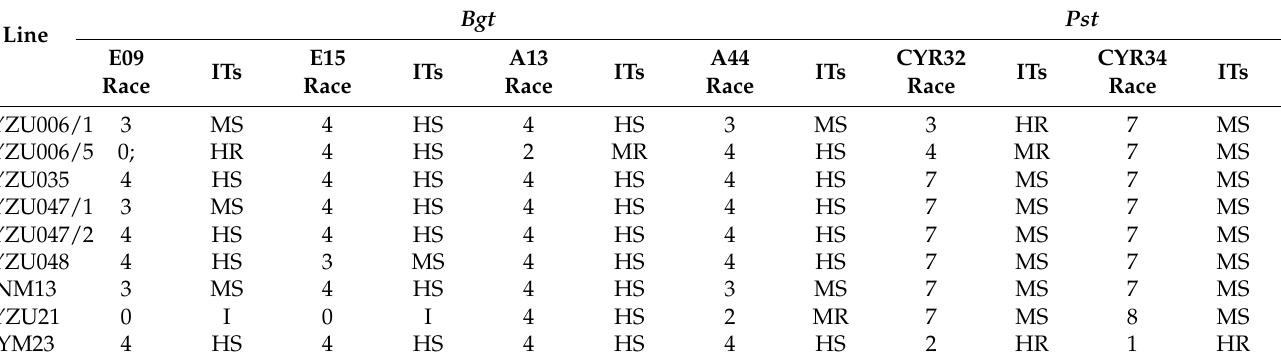
Table 4. Evaluation of resistance to powdery mildew and stripe rust of new lines.